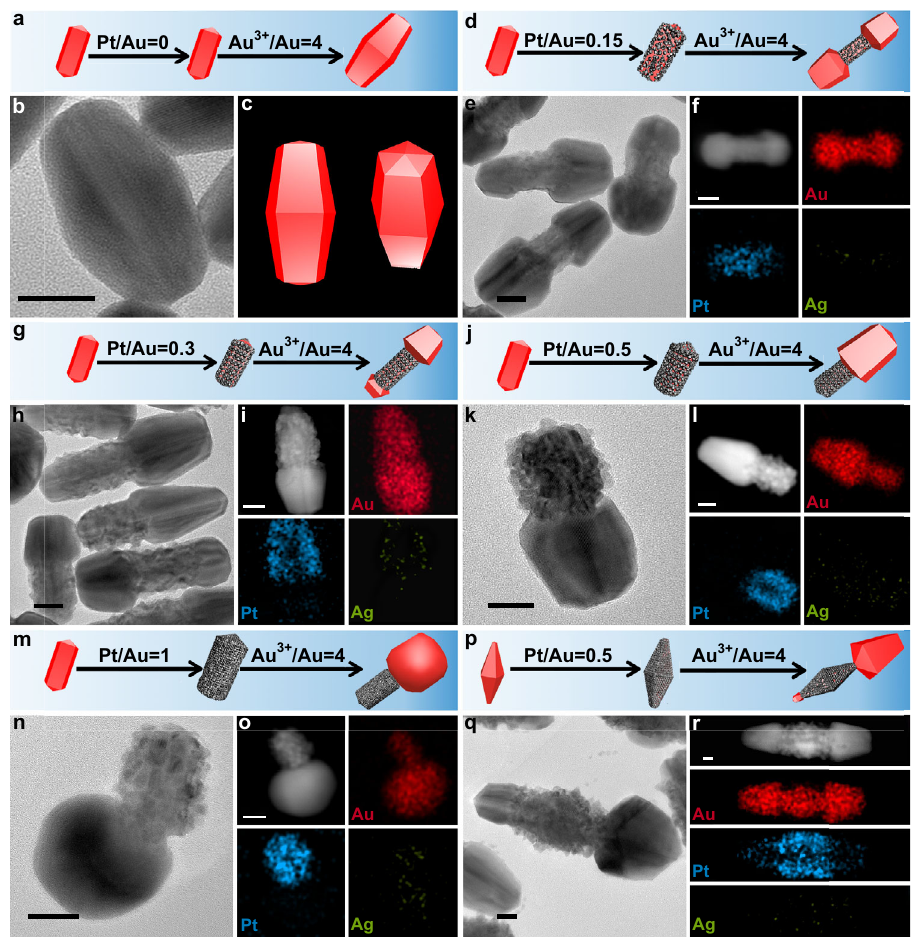
Fig. 5 Au growths on AuNR@Pt and AuNB@Pt nanocrystals. TEM images, STEM-HAADF images, STEM-EDS elemental maps, and schematic illustrations of products prepared through overgrowing Au on AuNR@Pt nanocrystals with different Pt/Au molar ratios: a , b , c 0; d , e , f 0.15; g , h , i 0.3; j , k , l 0.5; m , n , o 1. p , q , r TEM images, STEM-HAADF images, STEM-EDS elemental maps, and schematic illustrations of products prepared through overgrowing Au on AuNB@Pt nanocrystals. All scale bars are 20 nm. In all schematics, the red and gray colors represent Au and Pt,